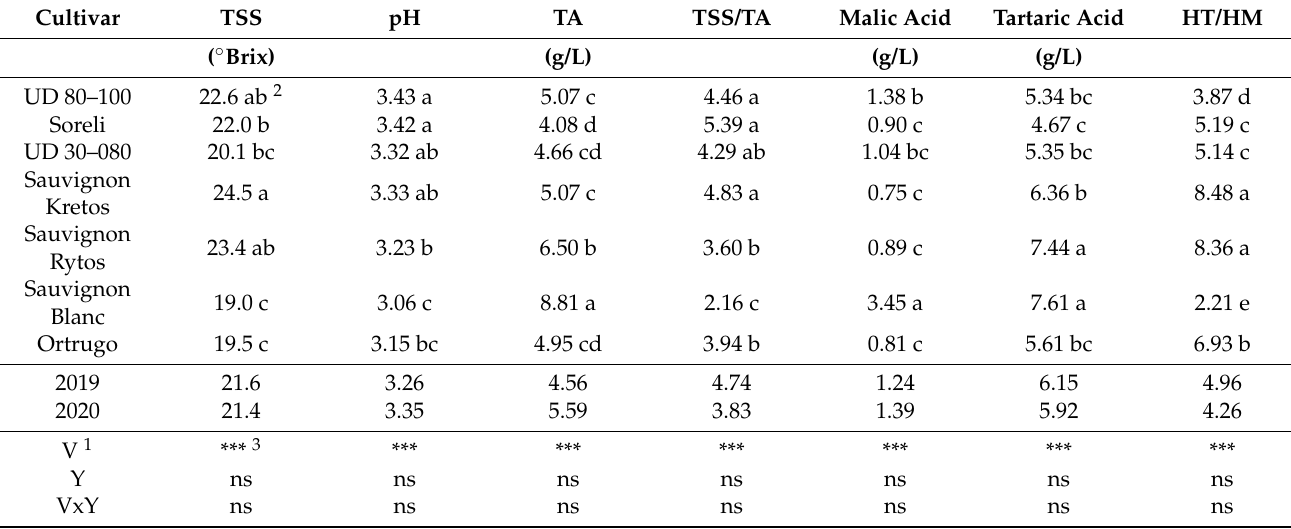
1 V = variety; Y = year. 2 Means within columns noted by different letters are different by SNK test. 3 *, ** and *** indicate significant difference per p ≤ 0.05, p ≤ 0.01 and p ≤ 0.001, respectively. ns: not significant. Sauvignon Blanc was the variety scoring the lowest TSS/TA and HT/HM ratio (2.16 and 2.21, respectively). Sauvignon Rytos had a TSS/TA ratio of 3.60, comparable to Ortrugo, and an HT/HM of 8.36, similar to Sauvignon Kretos (8.48). Ortrugo had a lower HT/HM Figure 6A shows that, if the tested varieties had been harvested at TSS = 20 ◦ Brix, the acid pool of Sauvignon Rytos would be mostly contributed by tartaric acid, whereas the acidity of Sauvignon Blanc would be also driven by higher malic acid. Sauvignon Kretos and UD 30–080 would exhibit comparable tartaric acid to Sauvignon Blanc but lower malic acid, resulting in a lower TA. Figure 6B shows the low TA of Ortrugo and Soreli at 20 ◦ Brix, linked to a very low malic acid concentration and relatively low tartaric acid level. Conversely, UD 80–100 would have retained a good balance between organic acids and total acids.